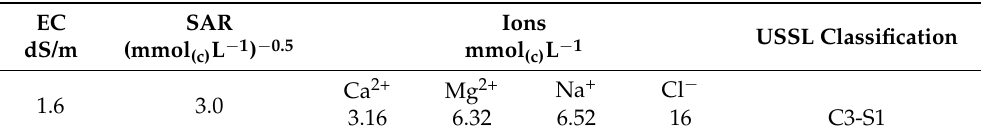
Table 2. Chemical characteristics of the irrigation water [15].